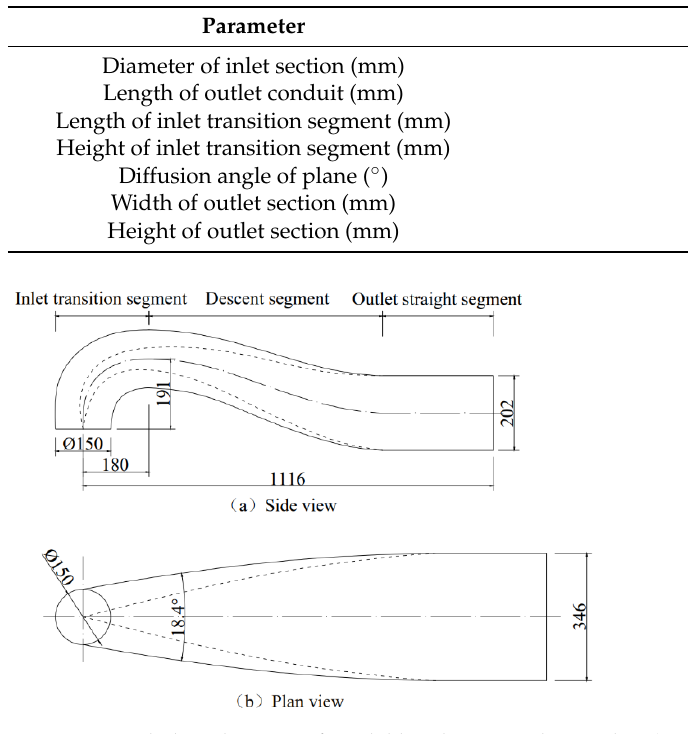
Figure 1. Single-line diagram of model low hump outlet conduit (unit: mm).